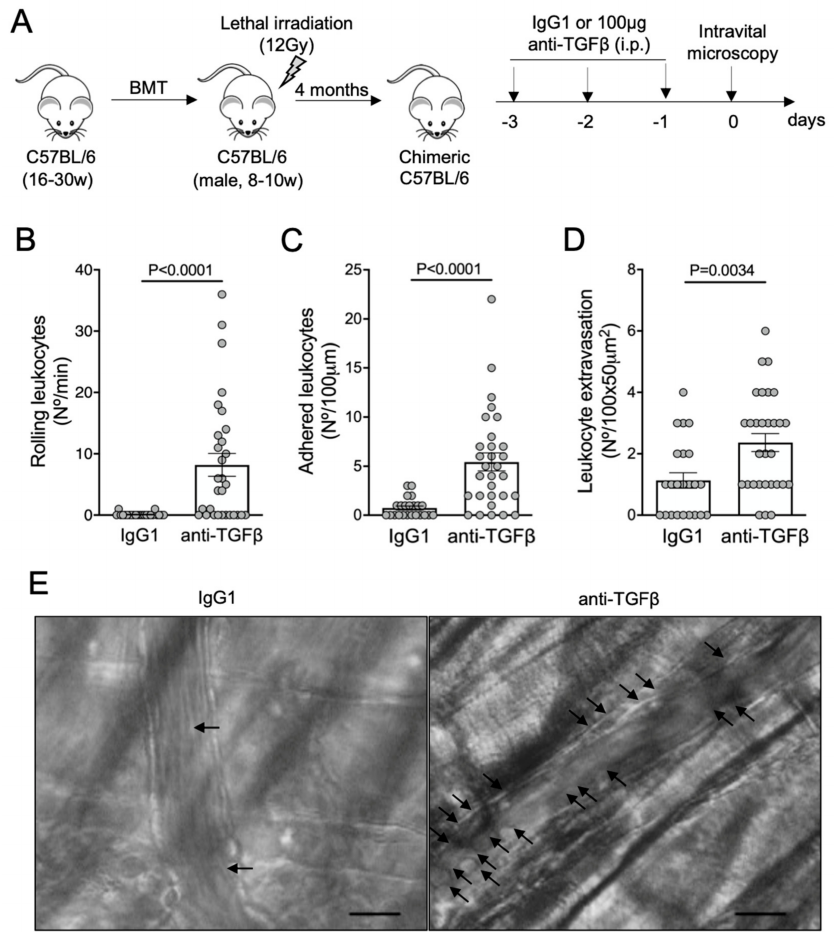
Figure 3. Vaso-occlusion in the microvasculature of C57BL/6 mice after neutralization of TGF- β : ( A ) experimental design. Chimeric C57BL/6 mice were generated by transplantation of bone marrow cells (BMT) from C57BL/6 donors into lethally irradiated (12Gy) C57BL/6 male recipients. After complete bone marrow repopulation (4 months), animals were injected with anti-TGF- β antibody (100 µ g, i.p.) or IgG1 isotype control for three consecutive days. On the fourth day, the microcirculation of the cremaster muscle was visualized by intravital microscopy; ( B ) number of rolling leukocytes (Nº/100 µ m/min); ( C ) number of leukocytes adhered to endothelium (Nº/100 µ m); ( D ) number of leukocytes extravasated to tissue (Nº/100 × 50 µ m 2 ). IgG1 group: N = 4 mice, 23 venules. Anti-TGF- β group: N = 4 mice, 30 venules. Mann–Whitney test for ( B , C ); Student’s t -test for ( D ); ( E ) representative images obtained during intravital microscopy (left: Video S5; right: Video S6). Arrows indicate leukocytes interacting with the endothelium (e.g., adhered or rolling). Scale bar = 20 µ